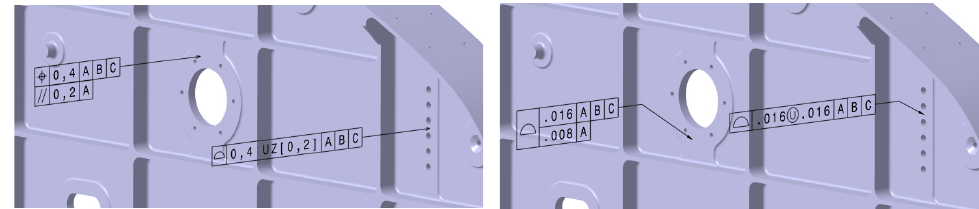
Figure A11. Aft web surfaces in ISO model ( left illustration) and Aft web surfaces in ASME model ( right illustration).